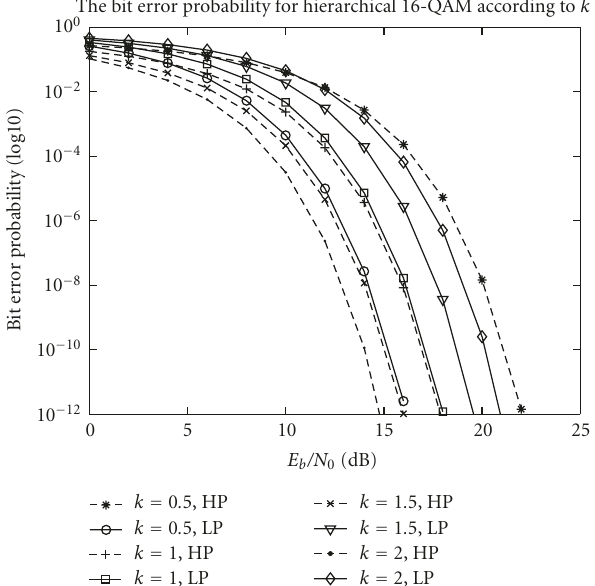
Figure 4: Bit error probability versus SNR per bit for various k values.